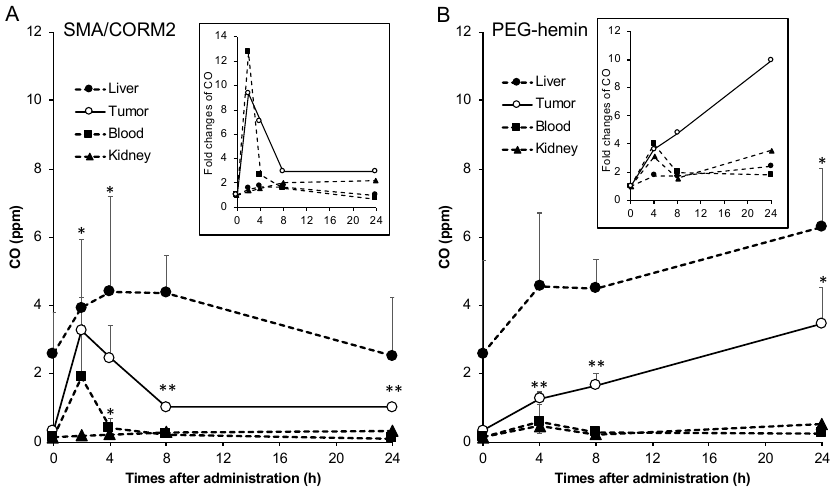
Figure 1. Generation of CO in the tumor and normal tissues after administering CO generators. Mice bearing colon C26 tumors (diameters of 10–15 mm) were used. SMA/CORM2 ( A ) and PEG-hemin ( B ) were injected i.v., and after a scheduled time, the mice were killed and the tumors and normal tissues were collected. To 100 mg of each tissue, 0.4 mL of a 0.01 M phosphate-buffered 0.15 M saline (PBS) was added and homogenized in test tubes, and 200 μL of saponin was then added. After 24 h of incubation at room temperature, CO in the test tube was quantified by gas chromatography. The inset shows the fold changes of CO in the tissues. *, p < 0.05; **, p < 0.01. The data are means ± standard deviation (SD), n = 3–4. See text for details.